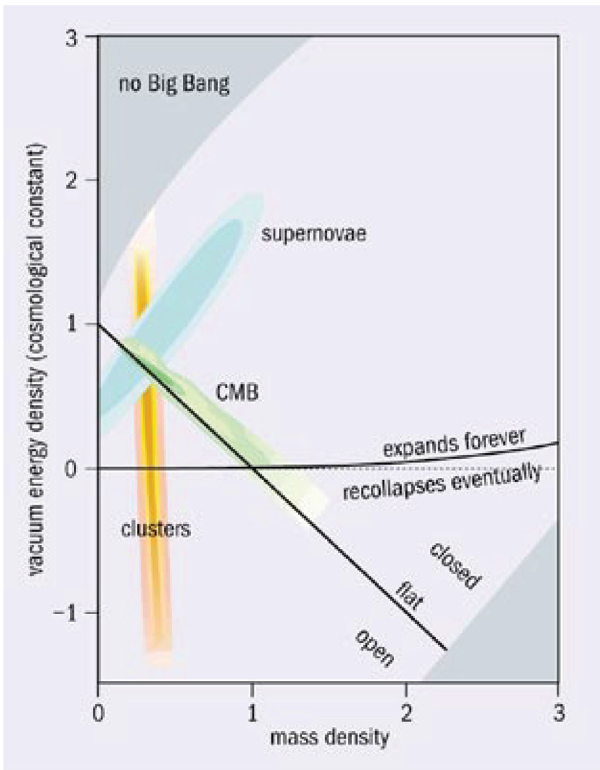
FIG. 29. Modified figure used in a media release. Image credit: